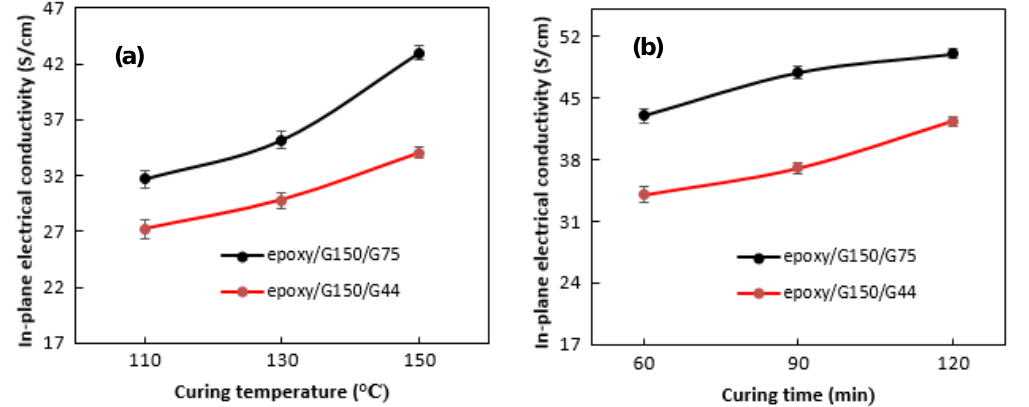
Figure 5. The in-plane electrical conductivity values of ( a ) epoxy/70 wt.% G150/10 wt.% (G44 or G75) prepared at 60 min and different curing temperatures; ( b ) epoxy/70 wt.% G150/10 wt.% (G44 or G75) prepared at 1 5 0 °C and different curing times.